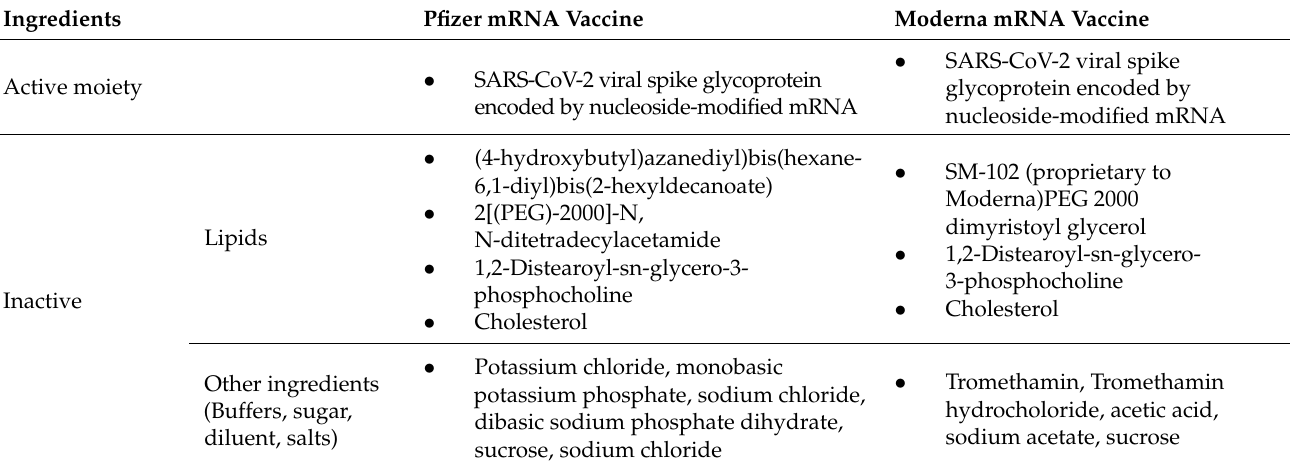
Table 3. Formulation ingredients of Pfizer and Moderna mRNA